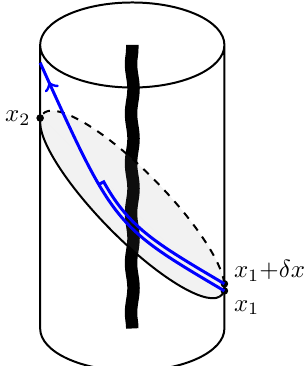
Figure 5 . In empty AdS, all lightrays from x 1 arrive at x 2 whether they pass through the boundary or bulk (the interior of the cylinder). When a macroscopic amount of energy (wavy black line) is added to the bulk, bulk geodesics like the thick blue one experience a time delay and may not even return to the boundary, thus washing out the Regge singularity at ( x 2 − x 1 ) 2 → 0 . In contrast, the folded OPE singularity between x 1 and x 1 + δx exists for any bulk